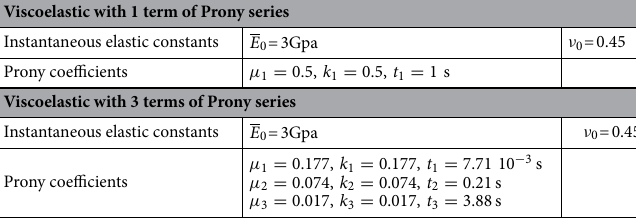
Table 1. Relevant properties of the viscoelastic